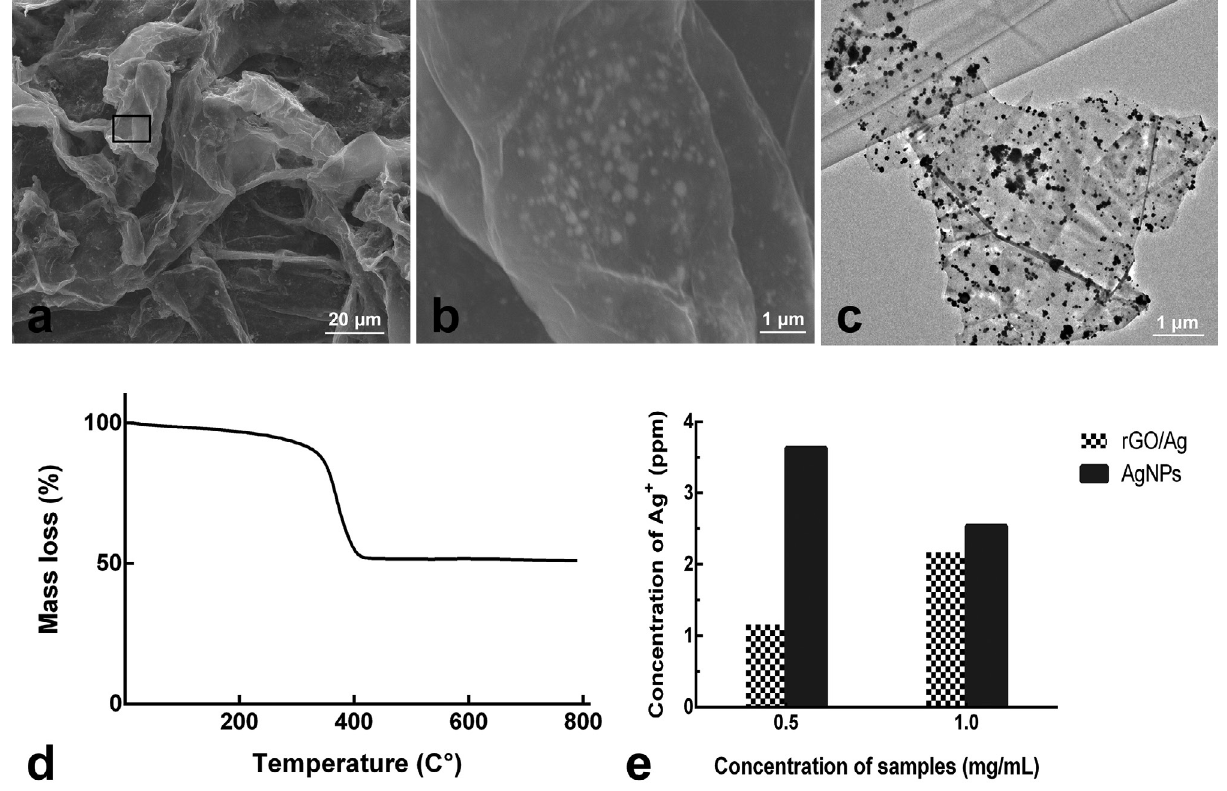
Figure 1- Characterization of the rGO/Ag composite. (a) scanning electron microscopy (SEM) image, (b) magnification of the area indicated by the black box in picture (a), (c) transmission electron microscopy (TEM) image, (d), thermogravimetric analysis (TGA) of rGO/ Ag composite, (e) concentration of Ag+ released from the tested samples